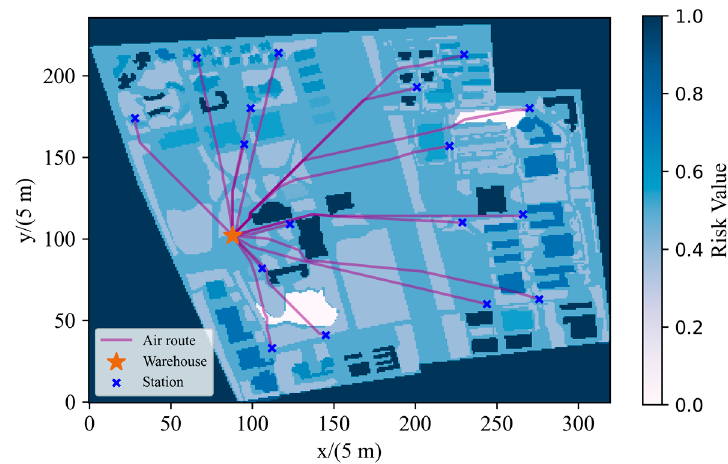
Figure 12. Public air route combined with the direct route for all stations.